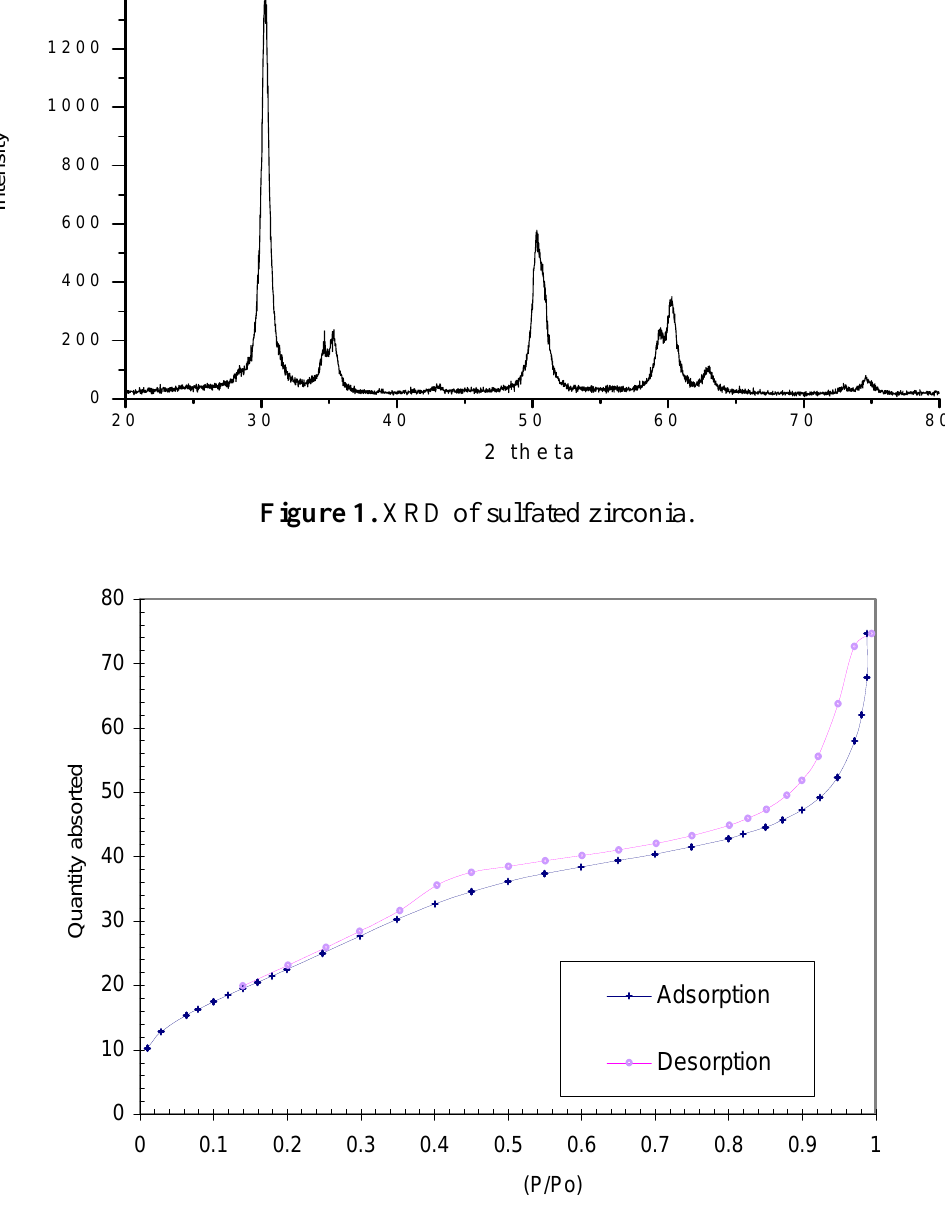
Figure 2. Nitrogen adsorption-desorption plot of